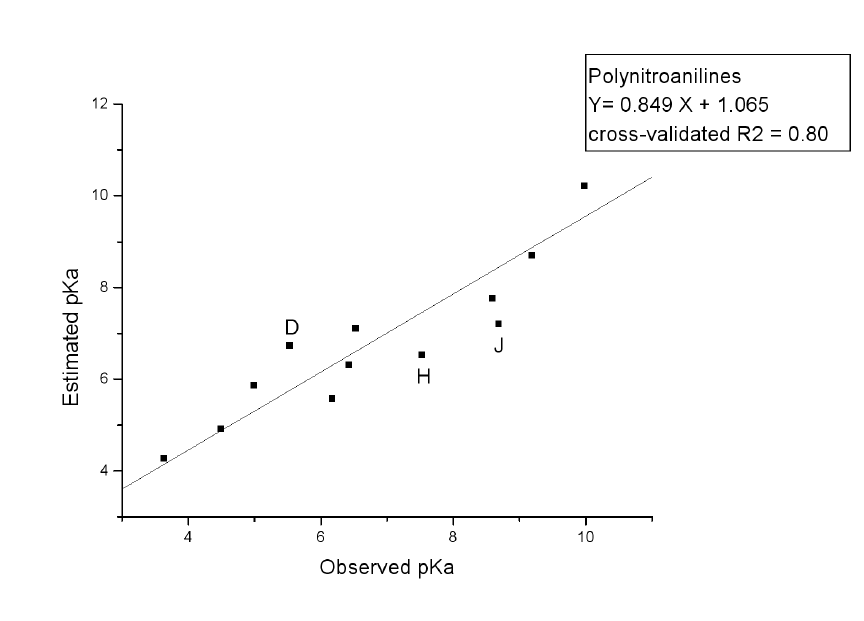
Fig. 2 Calculated versus observed acidity of thirteen N-methoxy-polynitroanilines 1